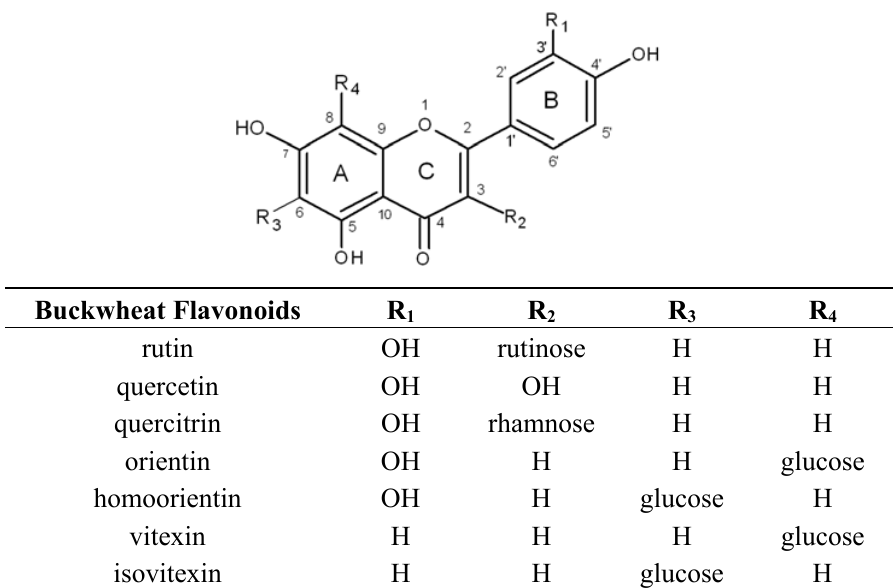
Figure 1. The chemical structure of buckwheat